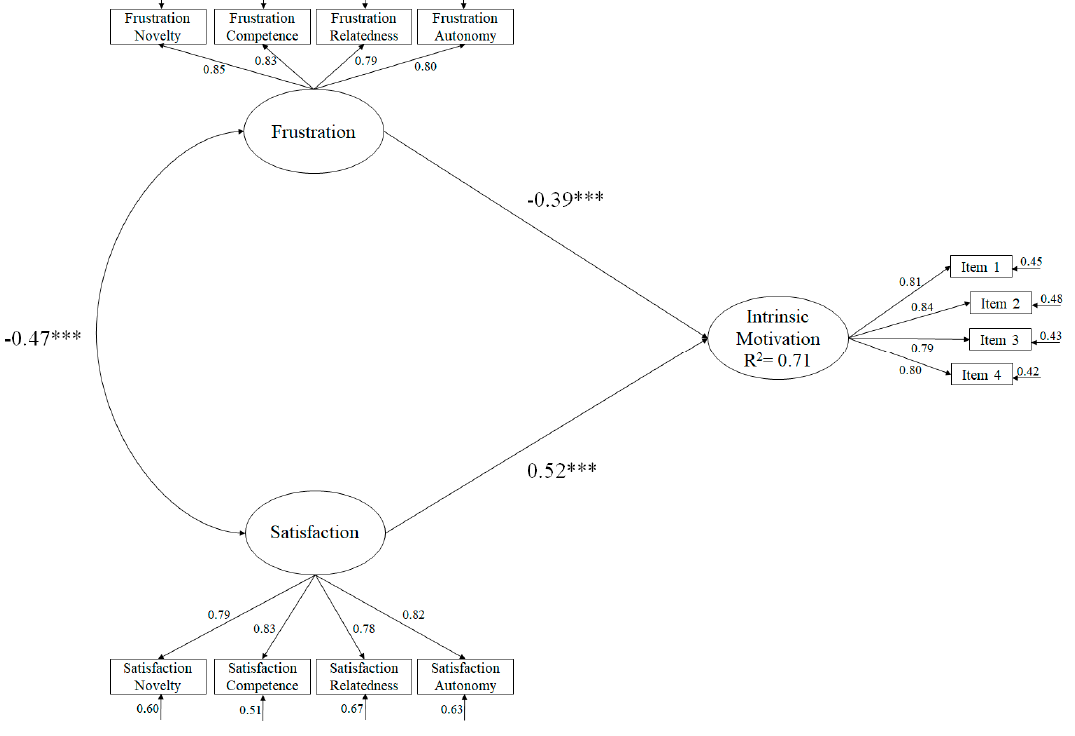
Figure 3. Structural equation model.